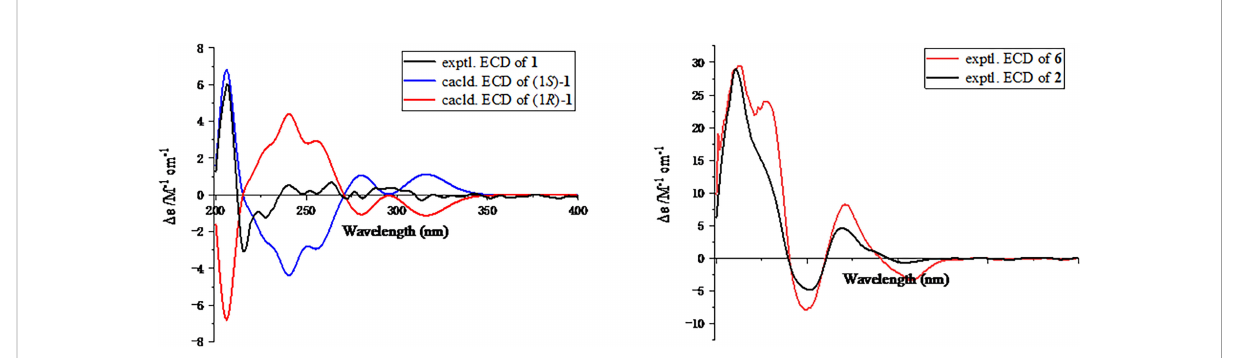
FIGURE 3 Experimental and calculated electronic circular dichroism spectra of compounds 1, 2, and 6